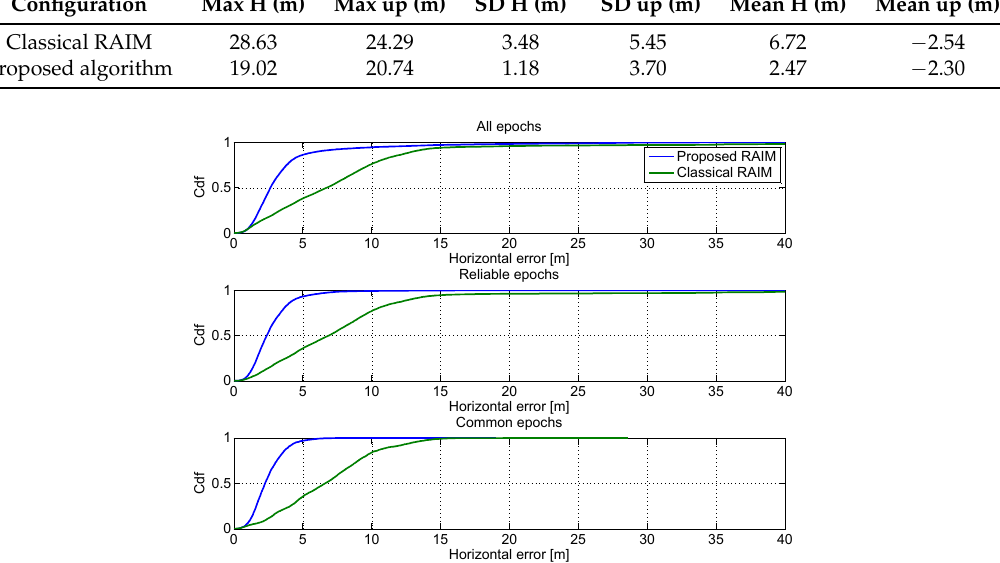
Figure 21. CDFs of the horizontal position errors when a classical RAIM approach is considered. Upper box: CDFs computed using all available epochs; central box: CDFs computed using only reliable epochs; lower box: CDFs computed using only reliable common